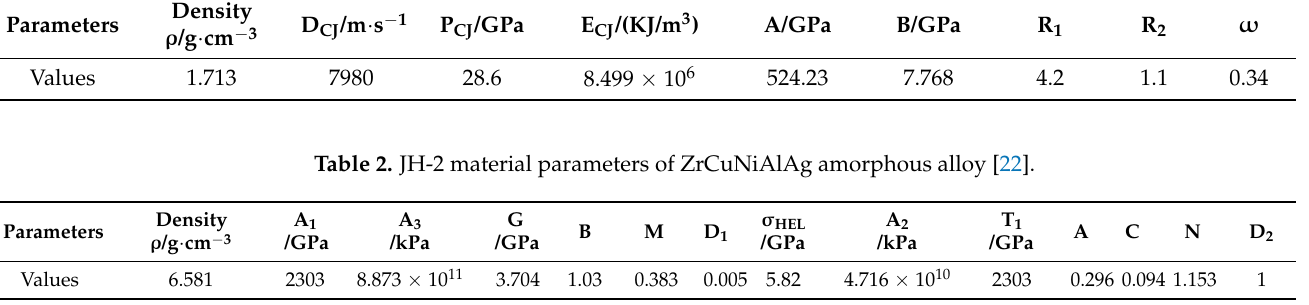
Table 1. Material parameters of the 8701 explosive [20,21].